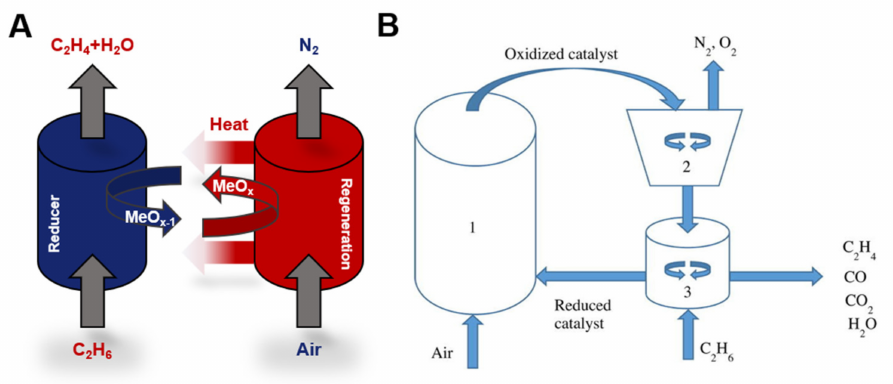
Figure 25. ( A ) Schematic for CL-ODH of ethane, and ( B ) ODHE in a fluidized bed reactor, Adapted from ref. [141], Copyright (2015), with permission from